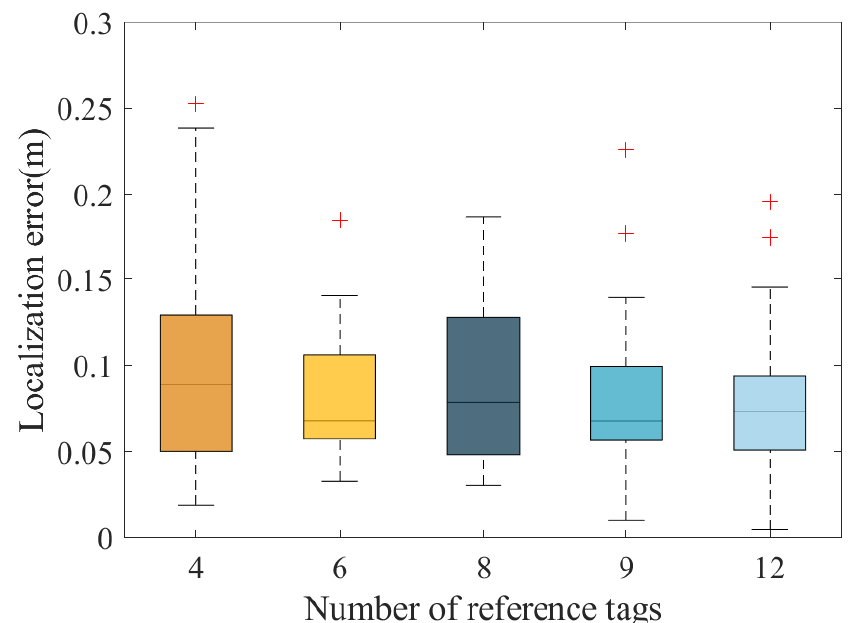
Figure 9. Number of reference tags selection.